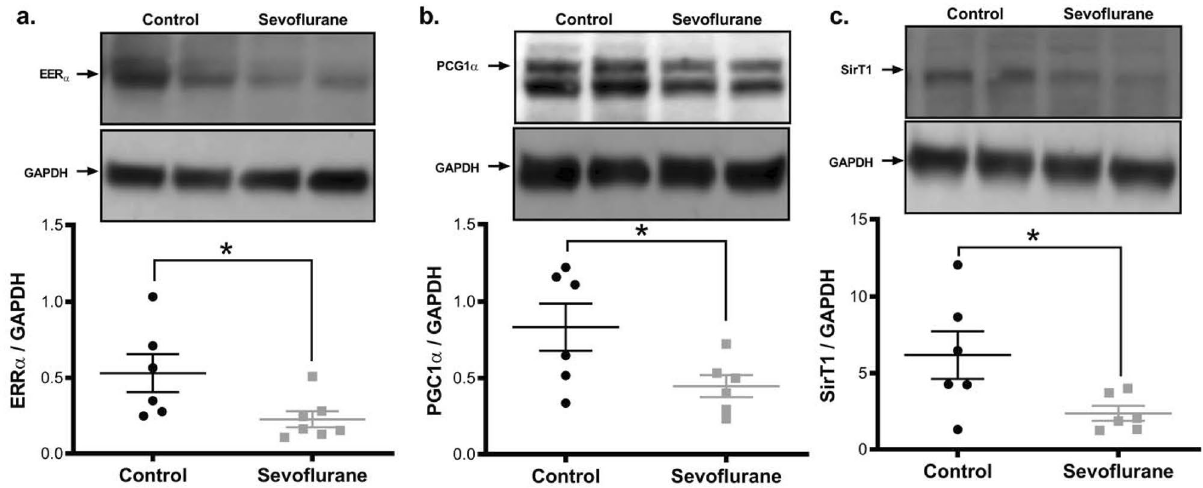
Figure 4. Adult cortical tissue demonstrates a lower level of mitochondrial biogenic regulators following infant sevoflurane exposure. Western blot analysis indicates sevoflurane exposed samples had a decrease in transcription factors responsible for mitogenic signaling/mitochondrial biogenesis (ERRα ( a ), PGC1-α ( b )) and transcriptional regulation (SirT1 ( c )), consistent with the reduction of cellular mitochondrial content and quality control. Values represent means ± SEM, with 6 animals in each group. Statistical significance between groups indicated with (*) for p -value < 0.05. All samples derived from same experiment and gels/blots processed in parallel.